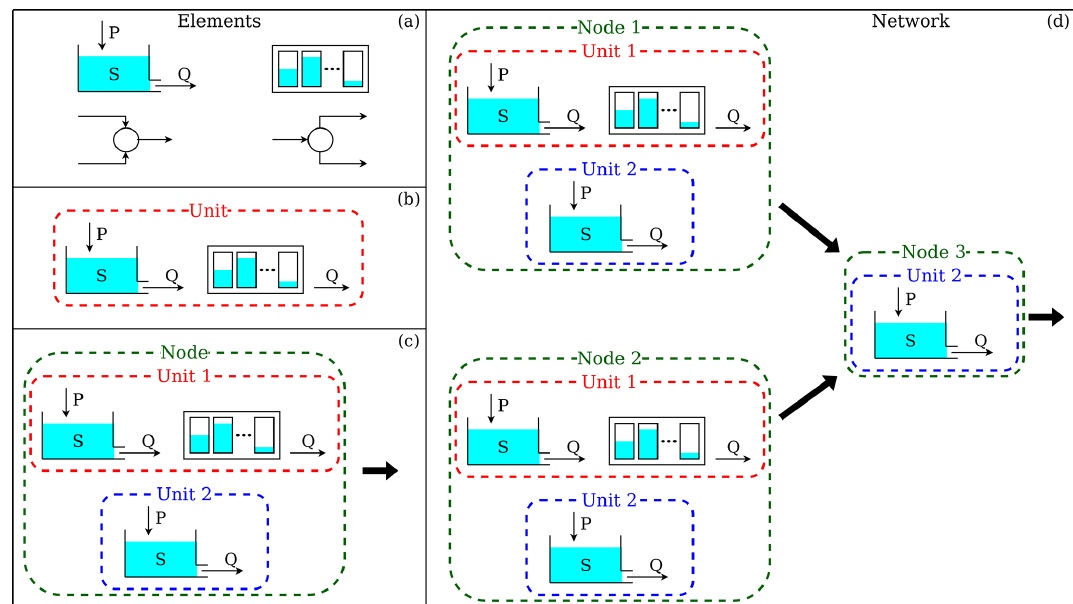
Figure 1. The four hierarchical levels of SuperflexPy and their respective components . (a) Elements (e.g., reservoirs, lags, connections) are used to represent individual hydrological processes/catchment response mechanisms. (b) Units connect multiple elements and are intended to implement lumped catchment models. (c) Nodes collect multiple units that operate in parallel representing different landscape elements within a catchment. (d) Network connects multiple nodes and is used to represent distributed